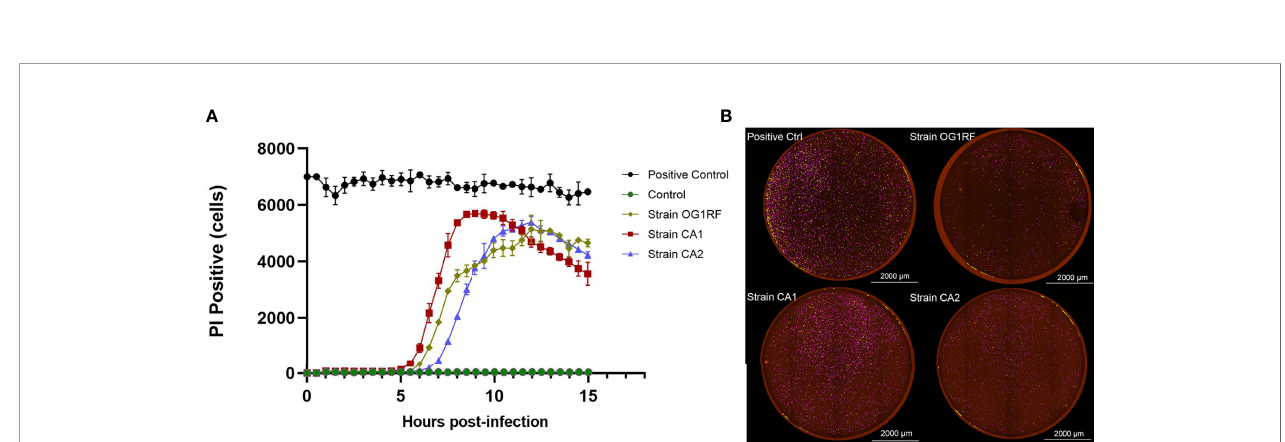
FIGURE 1 | Viability of extracellular and intracellular bacteria and real-time MOI changes in co-culture of E. faecalis and RAW264.7 cells. RAW264.7 cells seeded overnight in 12-well culture plates at 3×10 4 /well were infected with the E. faecalis CA1, CA2, or OG1RF strains at a multiplicity of infection (MOI) of 100:1. Extracellular and intracellular bacteria and RAW264.7 cells were counted at 2, 6, and 12 h of infection. (A) Viability of intracellular (I-strains) and extracellular (E- strains) bacteria [lg (CFU/10 4 cells)]. (B) Viability of RAW264.7 cells. (C) Real-time MOI of co-culture of E. faecalis and RAW264.7 cells. * P < 0.05, compared to the control group. # P < 0.05, compared to the OG1RF group, j P < 0.05 compared to the CA1 group.